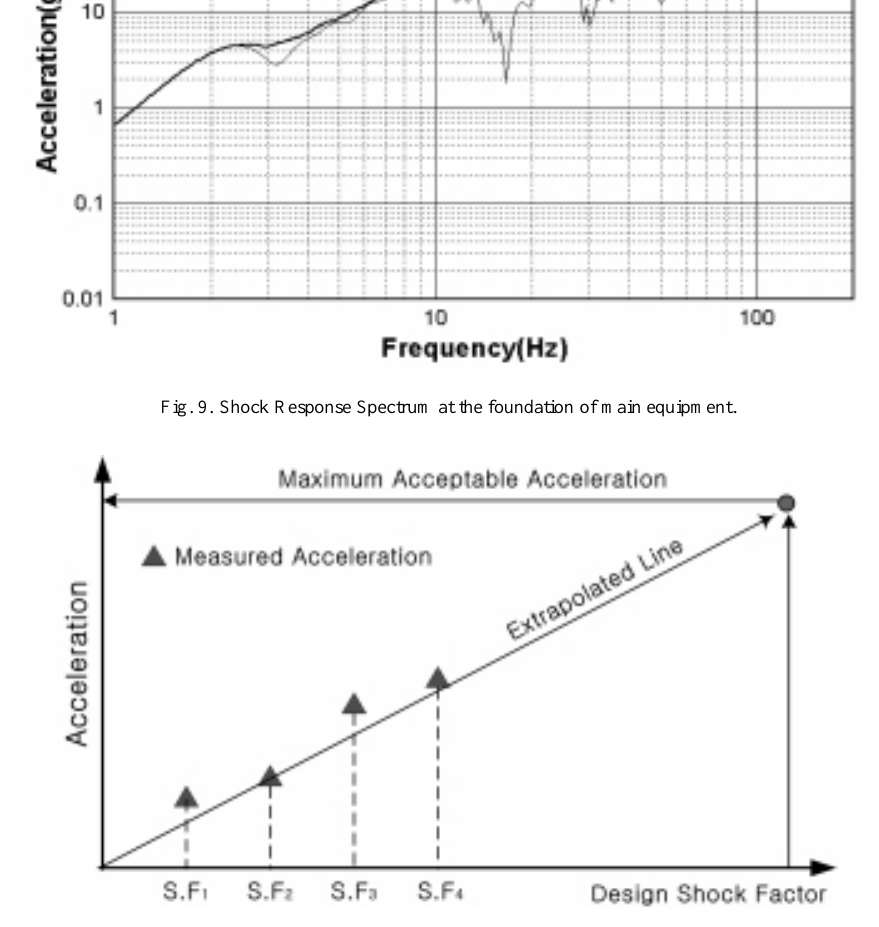
Fig. 10. Estimation of maximum acceptable